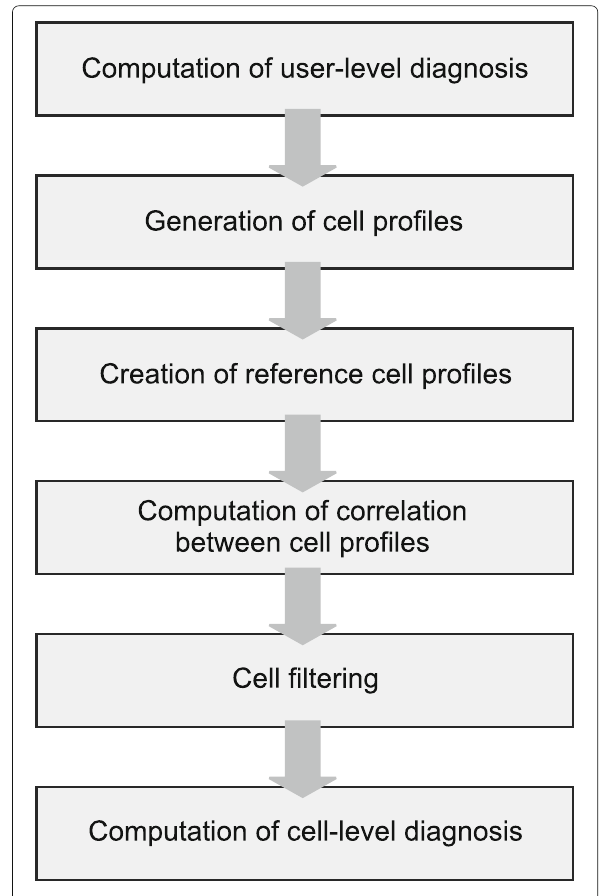
Fig. 6 Block diagram of the proposed cell-level correlation-based algorithm (cid:5) for faulty situations